Question: State the chart type depicted above.
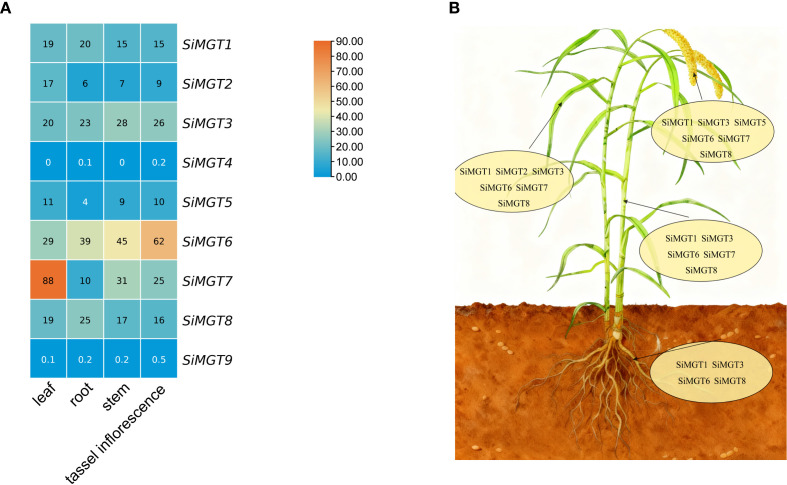
Answer: heatmap